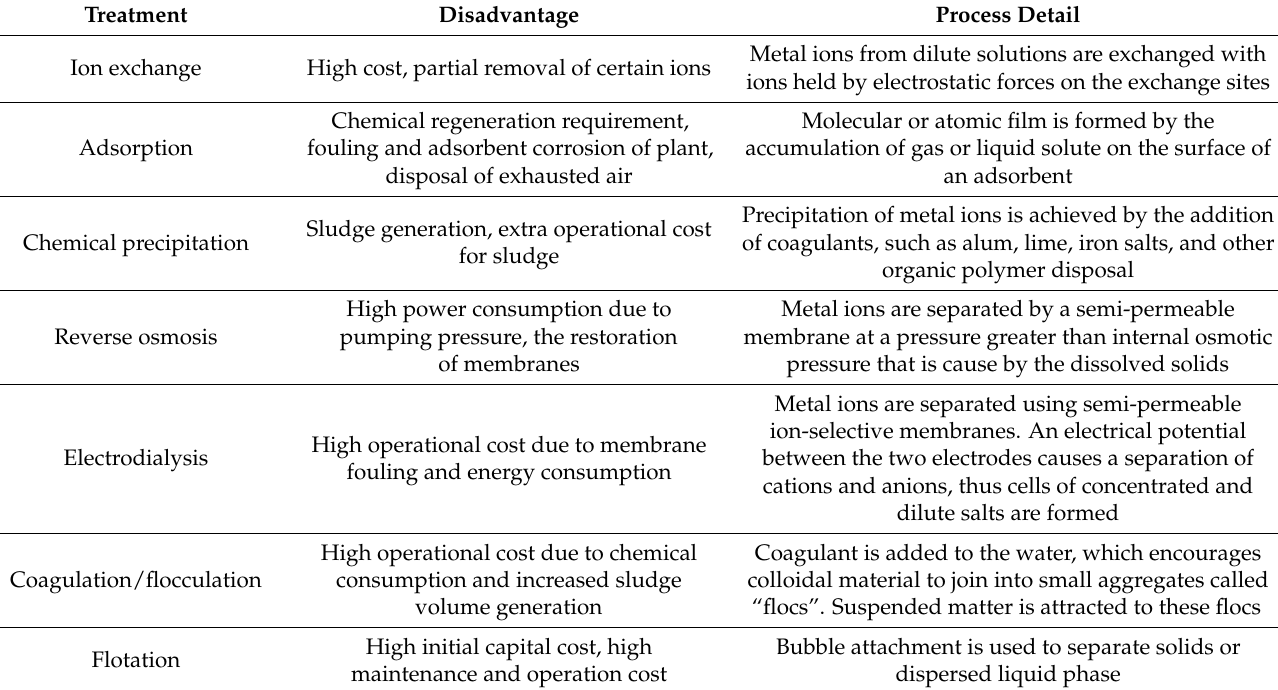
Table 1. Wastewater treatment processes and possible